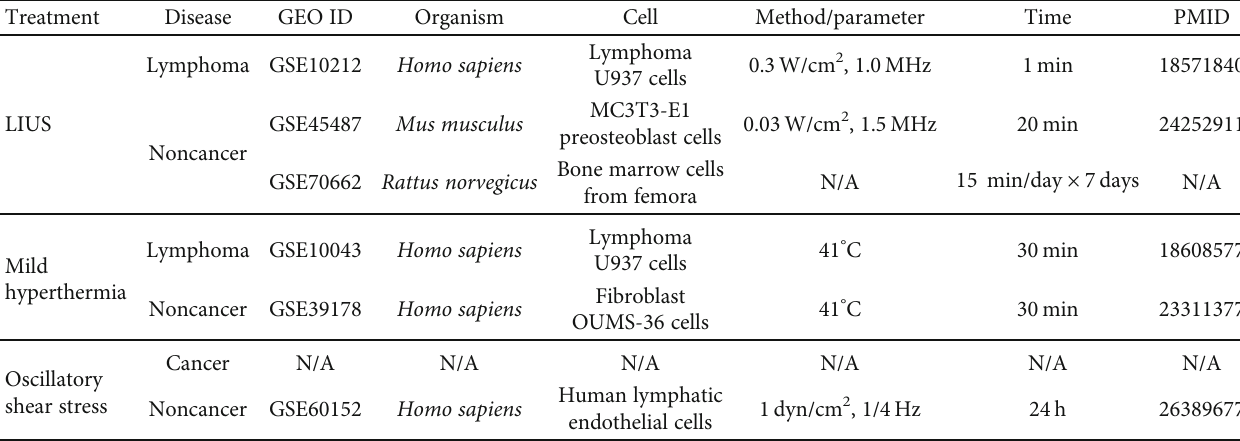
Table 1: The six studied microarray datasets included three low-intensity ultrasound- (LIUS-) treated, two mild hyperthermia-treated, one oscillatory shear stress-treated noncancer cells. (a) Detailed information of all the GEO DataSets (https://www.ncbi.nlm.nih.gov/gds/) that were used for the analyses are shown. (b) The expression level of housekeeping genes in the microarray datasets were not signi fi cantly changed. (a) Six microarray datasets were analyzed in the LIUS-related phenotypic